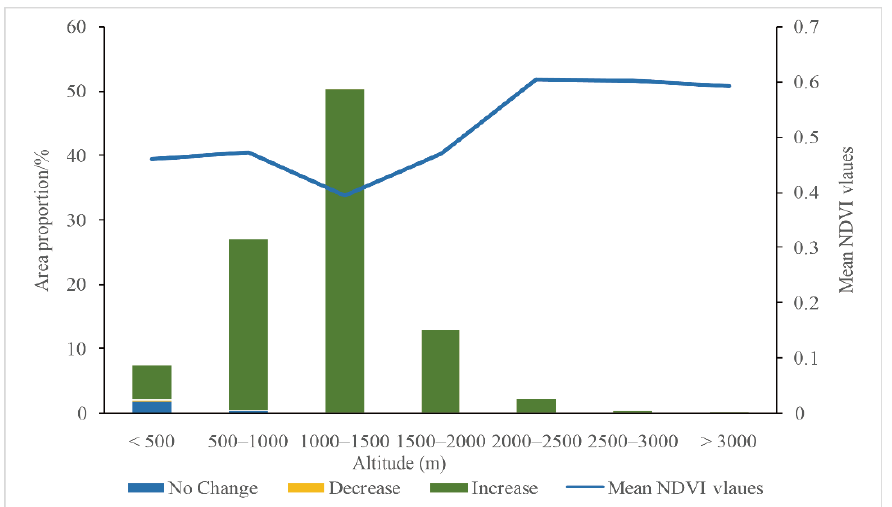
Figure 14. The relationship of NDVI change with elevation in Shaanxi Province (Note: “No Change”, ”Decrease”, and “Increase” in the legend means the annual average NDVI change trend of Shaanxi Province, referring to the Figure 7).